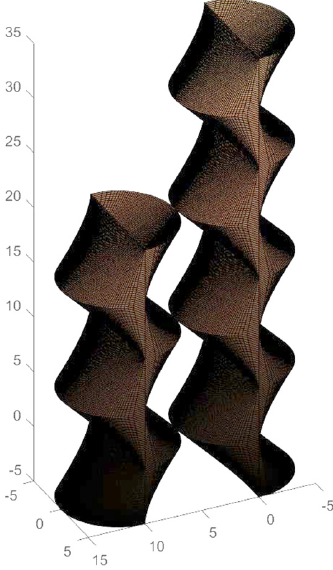
Figure 40. A pair of tubules of different height.